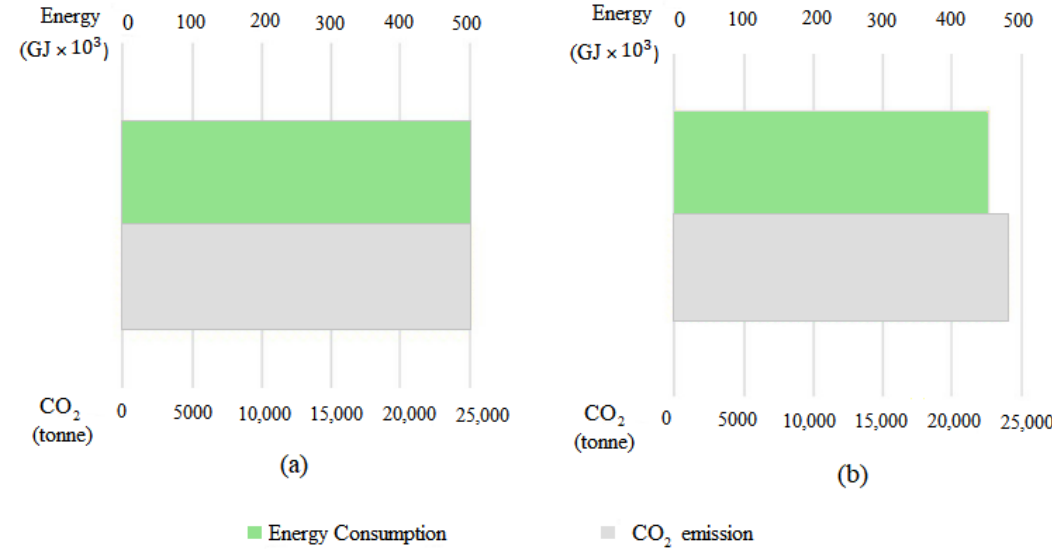
Figure 5. The annual consumption of energy and carbon dioxide emissions of current and lean modes related to erected steel frame buildings ( a ) under current mode ( b ) under lean mode